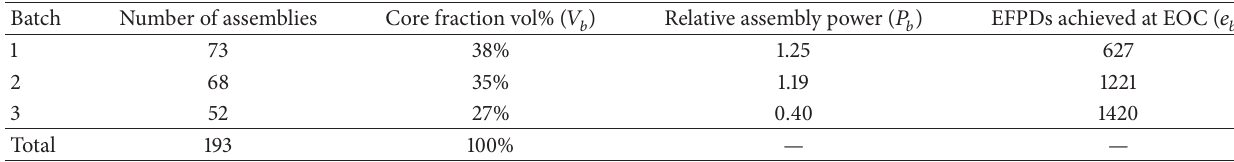
Table 2: Distribution in population and power per fuel cycle batch in a typical Westinghouse